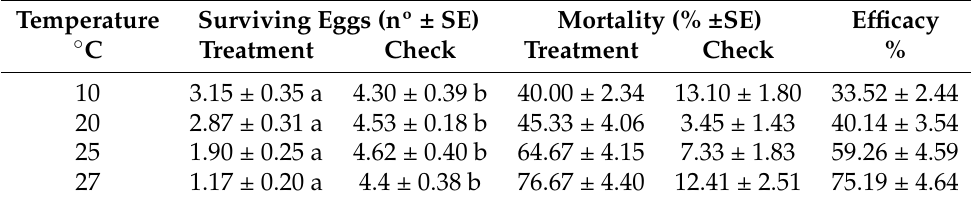
Table 1. Average values (±SE) of the predatory potential evaluated at 10, 20, 25, and 27 ºC.